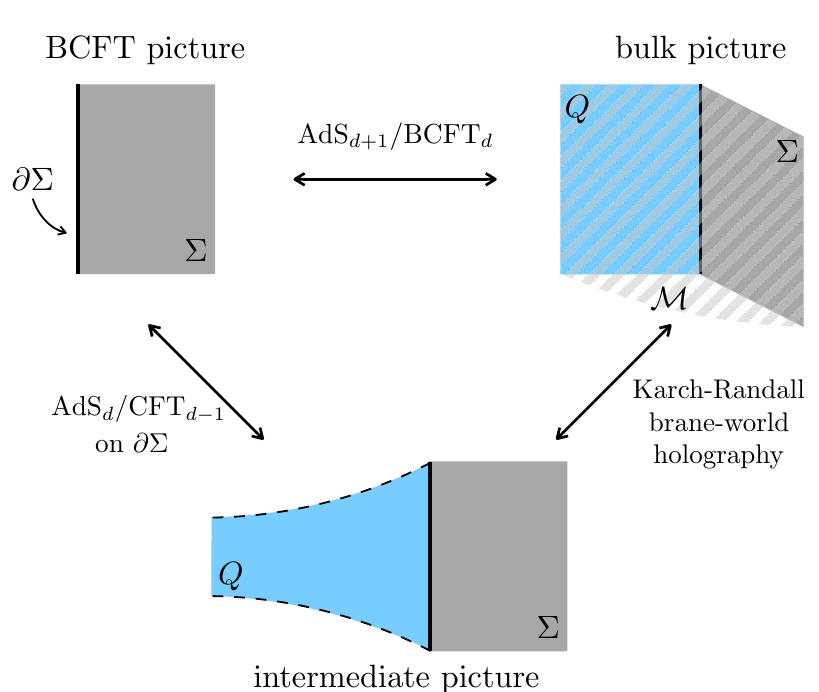
Figure 1 . The three equivalent pictures of a doubly holographic model. The asymptotic boundary Σ and the end-of-the-world brane Q are shown in grey and blue, respectively. The bulk region M is